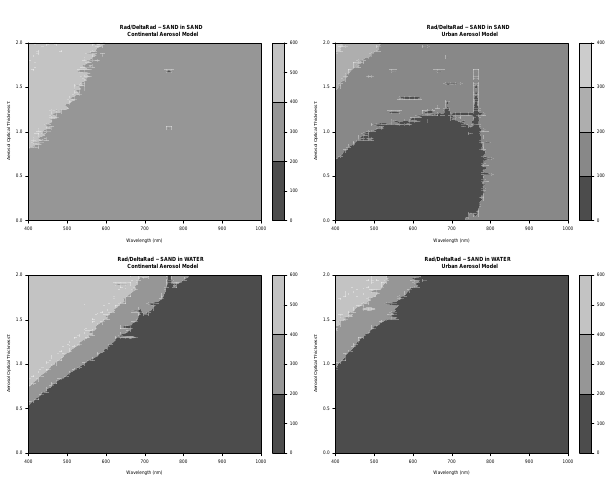
Fig. 7. The L(λ) in the PRISMA observed radiance simulated by 1L(λ) Fig.7. The L ( λ ) ∆ L ( λ ) inthePRISMAobserved radiance simulatedbyincreasingtheaerosolloading, τ a 550 ∈ ∈ { 0 . 00 − 2 . 00 } with 1τ a = increasing the aerosol loading, τ a { 0 . 00 − 2 . 00 } with ∆ τ a 550 =0 . 02 , forthesandsurfacegiventheenvironmentalcontributionofsand(first 550 550 row) and water (second row) under continental (first column) and urban (second column) aerosol model. 0 . 02, for the sand surface given the environmental contribution of sand (first row) and water (second row) under continental (first col- umn) and urban (second column) aerosol 27